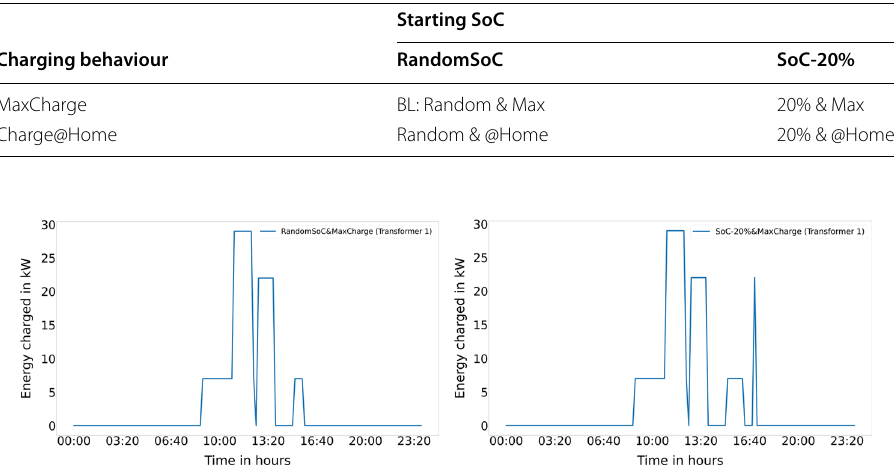
Fig. 11 Power profiles of transformer 1 for the baseline scenario with randomized (left) and 20% (right) SoC under the MaxCharge